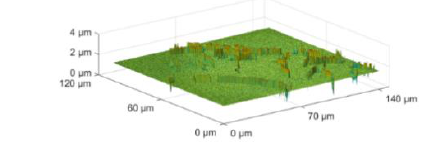
Fig. 5. Exponential Fitting of the SSD-percentage over depth of